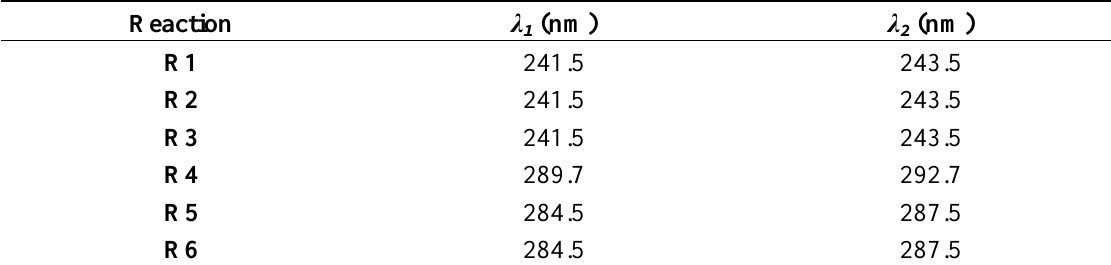
reaction R1 to R6